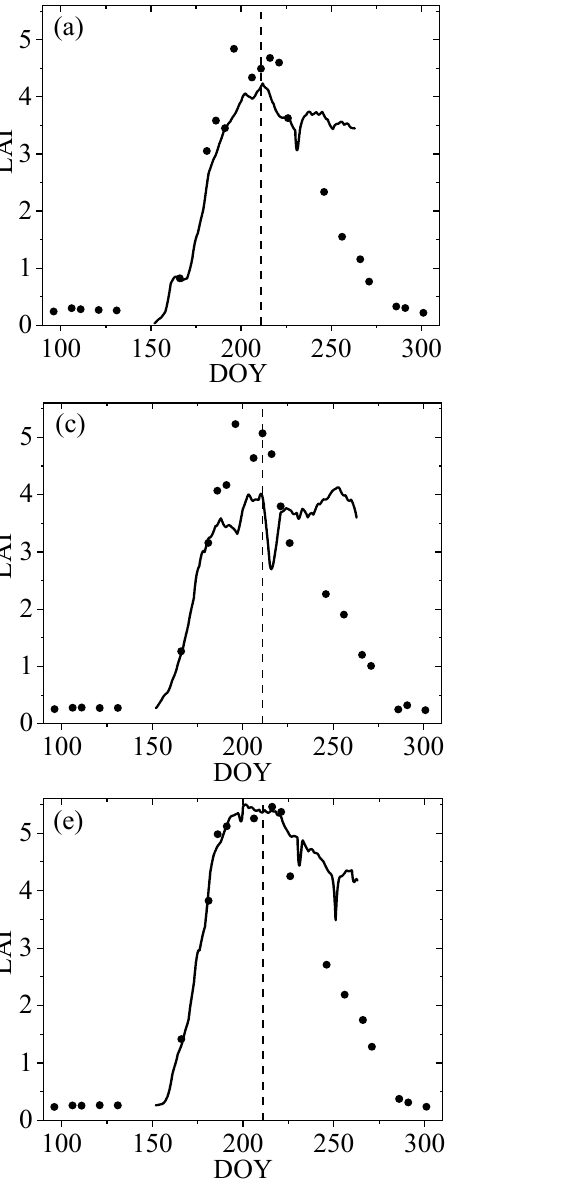
Figure 3. Time series of original Sentinel-2 LAI product (points) and LAINet (solid line) measurements for the six elementary sampling units ( a – f ) as indicated in Figure 1. The vertical dashed line at day of year (DOY) 211 indicates the timing of the maximum leaf development in our study area.